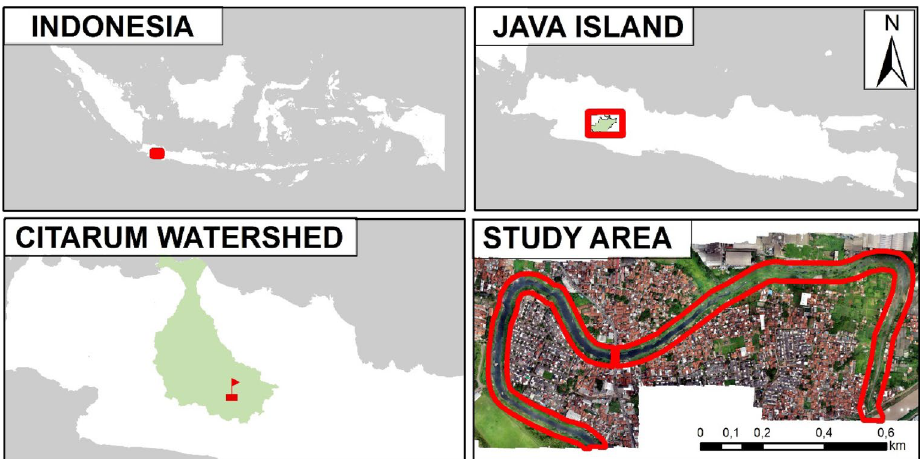
Figure 1. The location of open lotic-simple form type river as study area.